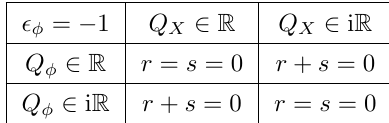
Table 2 . Conditions on the integers r and s for a timelike (cid:30) following from the Hermiticity of X . Imposing further (cid:30) to be Hermitian reduces all conditions to r = s = 0, in which case there are no solutions.